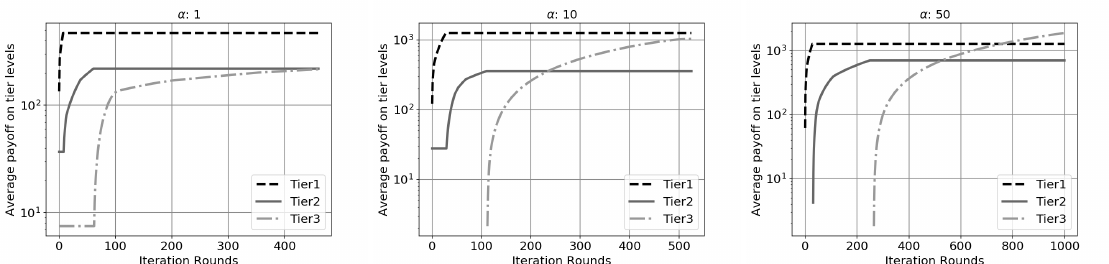
Figure 7. Payoff values in the simulation plotted by tier in case of various α values with a balanced tree-like